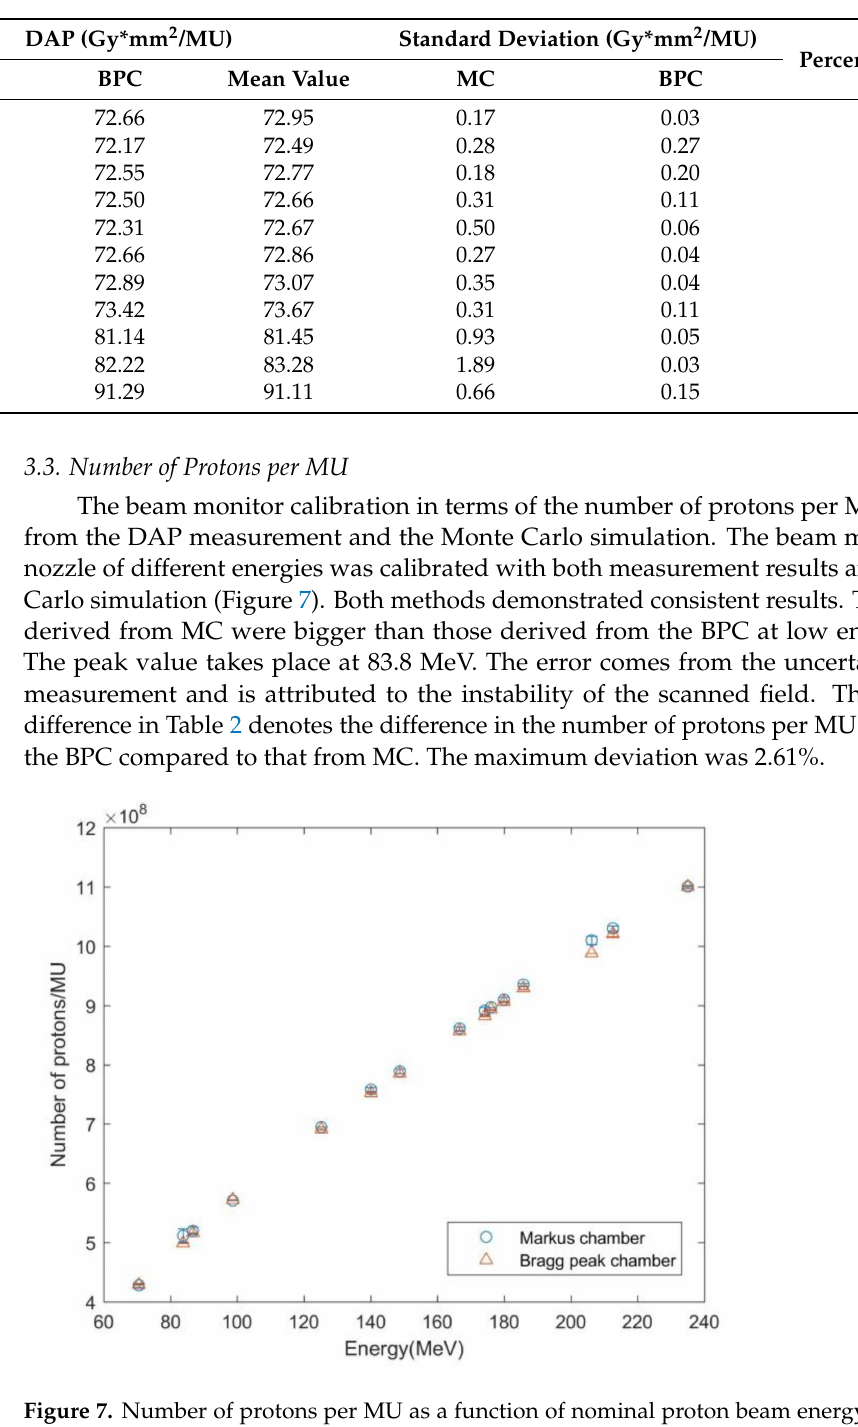
Table 1. DAP and the standard deviation measured with Markus chamber and Bragg peak chamber.